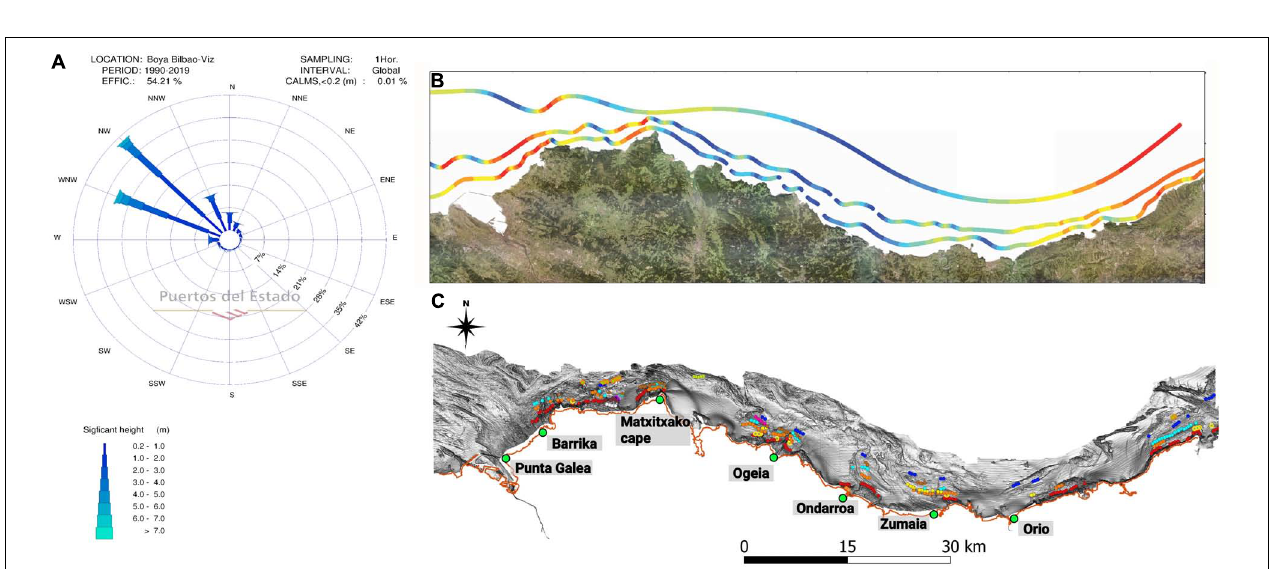
FIGURE 9 | Modeled profiles of the LEM for the three scenarios tested for the formation of the sequence of submerged marine terraces (A–C) . Numbers in gray boxes are the depth of the detected submerged shorelines within the models. Dashed lines indicate depth every 5 m. Asterisks are shorelines automatically extracted by the LEM. The slope and initial erosion rates to generate those profiles were set 2 ◦ and 1 m/a for scenarios (A , B) ; and 0.5 m/a, respectively, for scenario (C) .